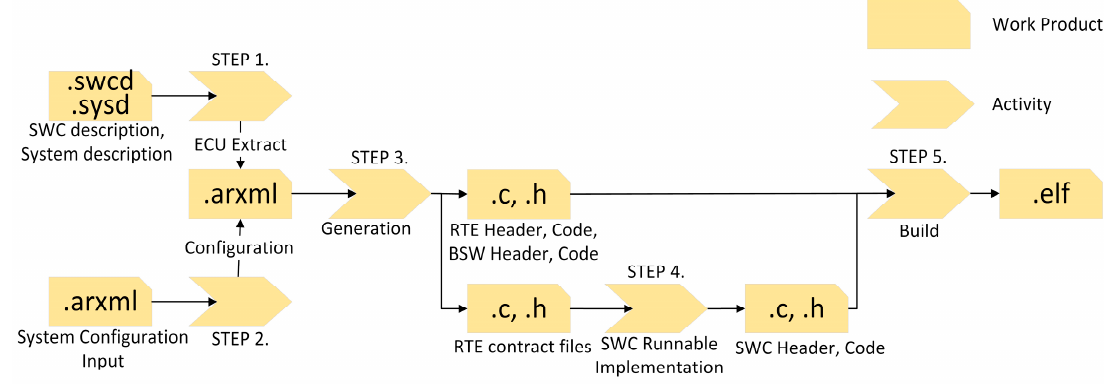
Figure 3. Open source AUTOSAR procedure.